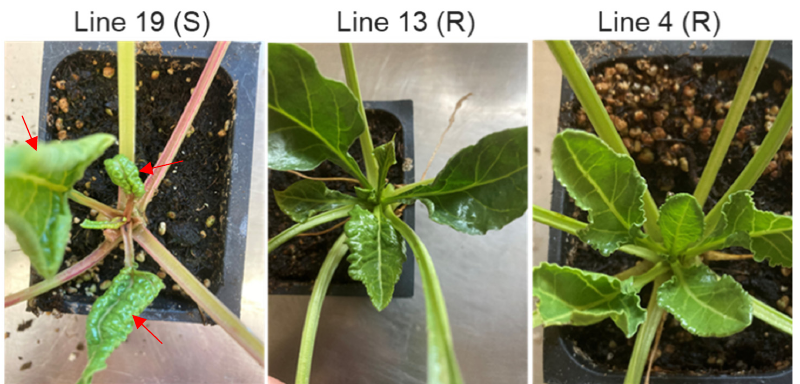
Figure 9. Disease symptoms in sugar beet plants that were previously infected by beet curly top virus (BCTV). Disease symptoms (leaf curling and swelling) in the apical leaves (indicated by red arrows) of beet curly top virus (BCTV)-susceptible (S; Line 19) and BCTV-resistant (R; Line 13 and Line 4) genotypes at 4 weeks post inoculation (wkpi).